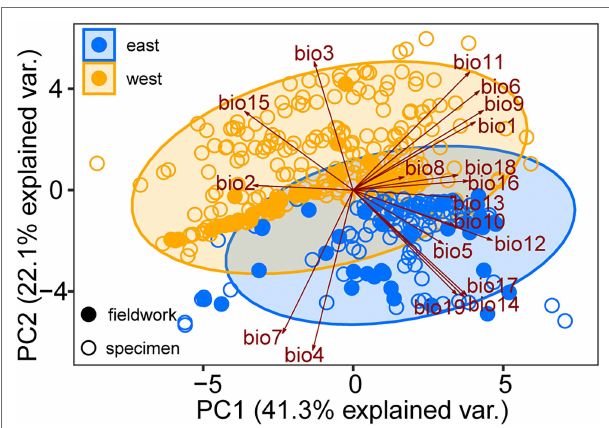
FIGURE 4 | Principal component analysis (PCA) performed with 19 bioclimatic variables ( Supplementary Table S3 ) for the specimen records (open dots) and sampling sites (solid dots) of Toxicodendron vernicifluum . Presence points of the western and eastern groups are marked in orange and blue colors,